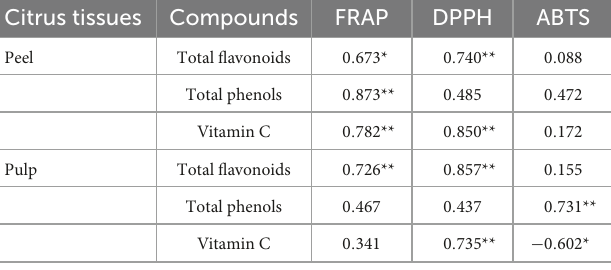
TABLE 3 Correlation analysis of total phenols, total flavonoids, and vitamin C content and antioxidant activity in peel and pulp. Citrus